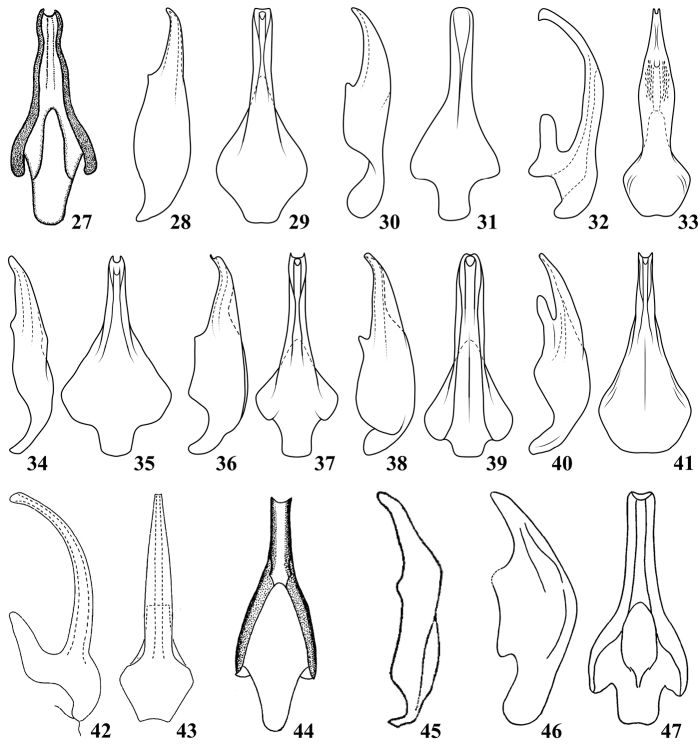
Aedeagus of Oncopsis in Sichuan, lateral (28, 30, 32, 34, 36, 38, 40, 42, 45–46) and ventral (27, 29, 31, 33, 35, 37, 39, 41, 43–44, 47) views 27O.anchorous (after Xu et al. 2006) 28–29O.furca30–31O.fusca (after Lauterer and Anufriev 1969) 32–33O.graciaedeagus34–35O.hailuogouensis36–37O.kangdingensis38–39O.kuluensis40–41O.ludingensis42–43O.melichari (after Lauterer and Anufriev 1969) 44O.nigrofasciata (after Xu et al. 2006) 45O.trimaculata (after Kuoh 1992) 46–47O.tristis (after Tishechkin 2017).